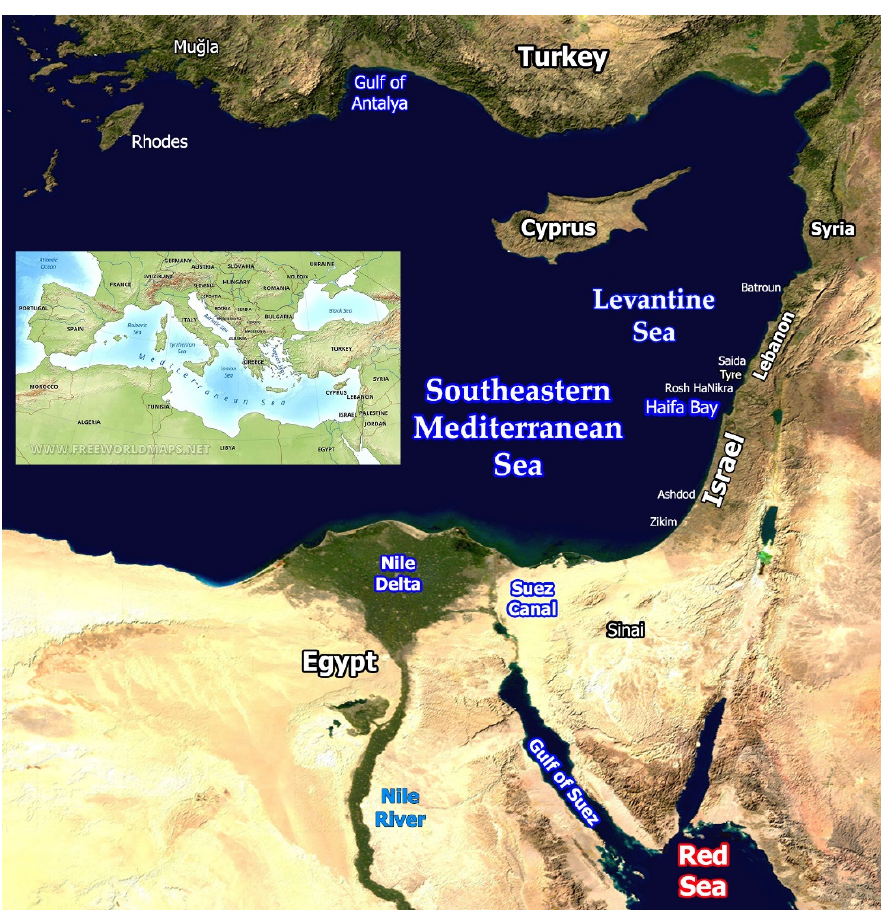
Figure 1. Eastern Mediterranean. Background: part of “Blue Marble: Land Surface, Shallow Water, and Shaded Topography”. NASA Goddard Space Flight Center Image by Reto Stöckli, Robert Simmon and MODIS Groups; visibleearth.nasa.gov/images/57752/blue-marble-land-surface-shallow-water-and-shaded-topography (accessed on 11 February 2002). Inset: Physical Map of the Mediterranean Sea and its surroundings. www.freeworldmaps.net/europe/mediterranean/physical.html, accessed on 20 December 2002.